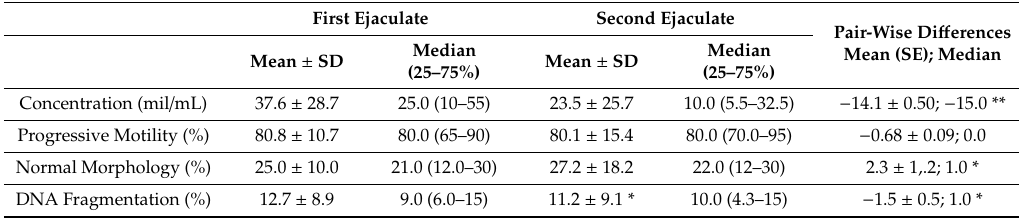
Table 3. Conventional sperm parameters and DNA fragmentation of two consecutive ejaculates of normozoospermic men separated by swim-up ( n = 30).